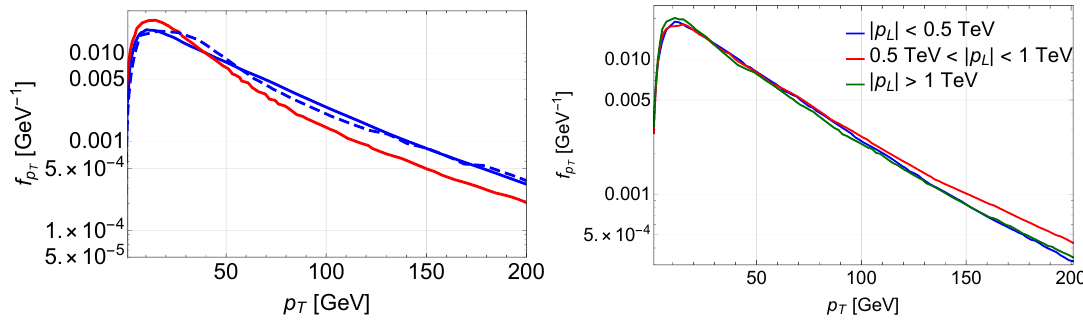
Figure 9 . Left panel : a comparison of p T spectra of Higgs bosons obtained in our simulations (solid blue line) with the spectra from [72] (dashed blue line) and [75] (red line). See text for details. Right panel : the p T distribution of Higgs bosons for di(cid:11)erent domains of j p L j